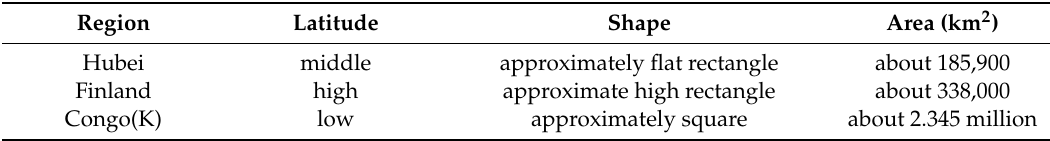
Table 2. Parameters of target regions.